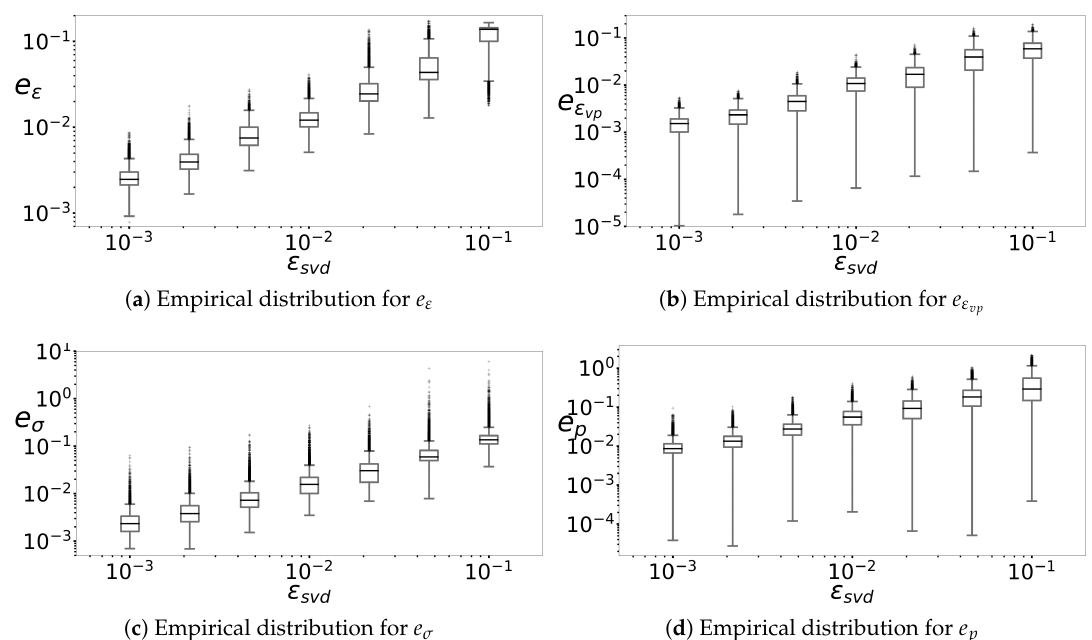
Figure 5. Empirical distribution of the relative approximation error for every mechanical variable.